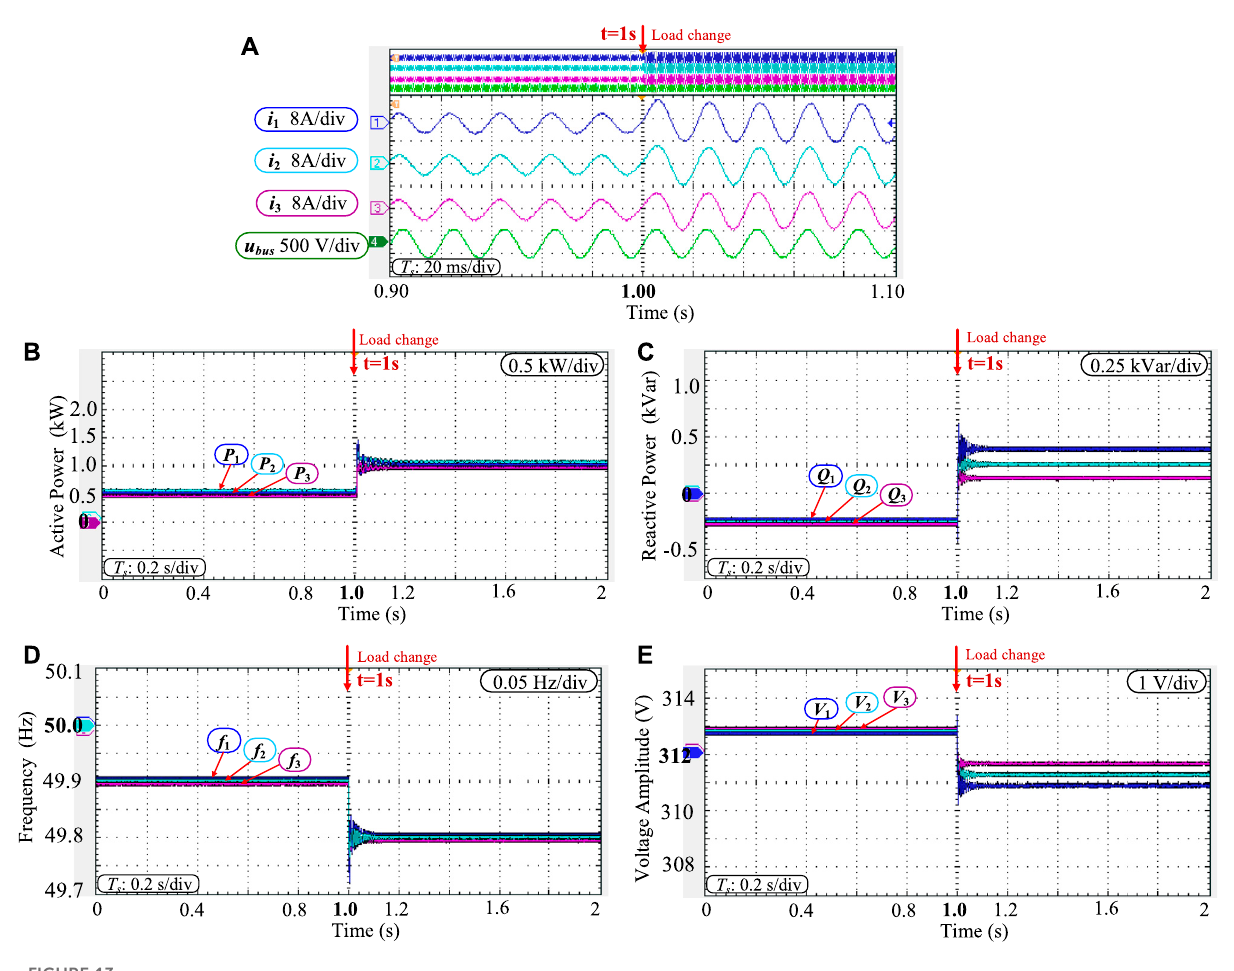
FIGURE 13 Experimental results under the equally resistive-inductive line characteristics. (A) output waveforms; (B) active power; (C) reactive power; (D) frequency; (E) voltage